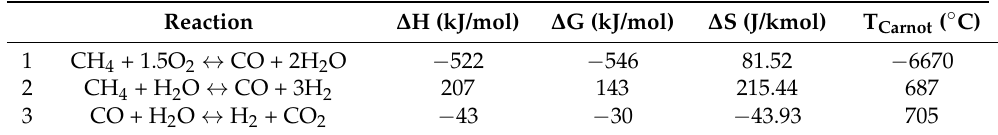
Table 3. Autothermal reforming reactions